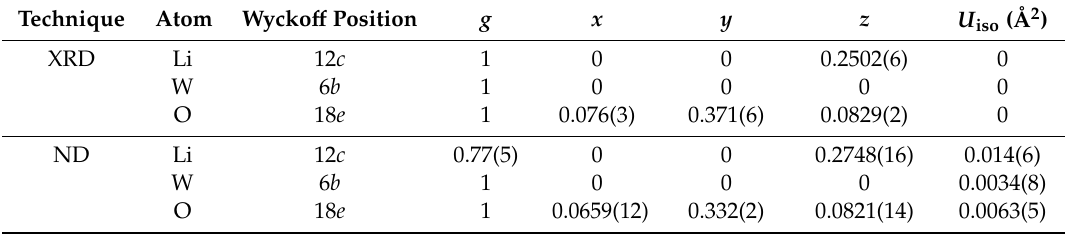
Figure 3. Rietveld refinement of ( a ) XRD and ( b ) ND data for Li x WO 3 ( x = 0.8) assuming the LiNbO 3 -type ( R 3 c ) structure. Red crosses, green solid line, and blue solid line represent observed, calculated, and difference intensities, respectively. The top and bottom green ticks indicate the positions of the Bragg peaks of the LiNbO 3 -type structure and the cubic ( Im −3) phase with x ~ 0.5 (see text for details). Table 1. Structural parameters of Li 0.8 WO 3 from Rietveld refinement on XRD and ND data at 300 K. g is the site occupancy factor. XRD: a = 5.1626(4), c = 13.4434(2) Å , R wp = 12.43, R p = 9.21% and GOF = 2.24. ND: a = 5.1665(3), c = 13.4424(10) Å , R wp = 8.95, R p = 6.72% and GOF = 1.16.